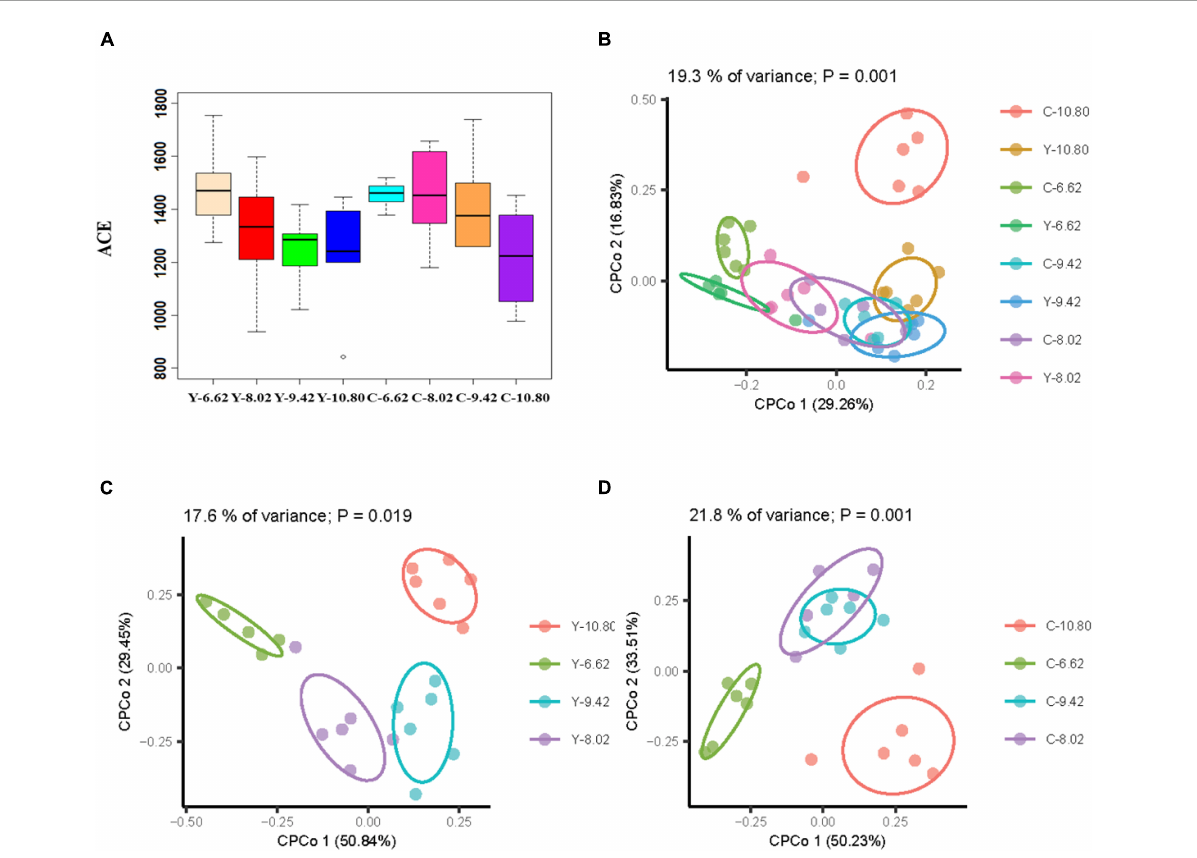
FIGURE2 Effects of dietary energy levels on α and β diversity of the ruminal bacterial community in yak (Y) and in Qaidam cattle (C) offered low protein diets differing in energy levels (MJ ME/kg DM). (A) Ace index between the bovine species and among dietary energy levels; (B) CPCoA between the bovine species and among dietary energy levels; (C) CPCoA among dietary energy levels for yaks; (D) CPCoA among dietary energy levels for Qaidam